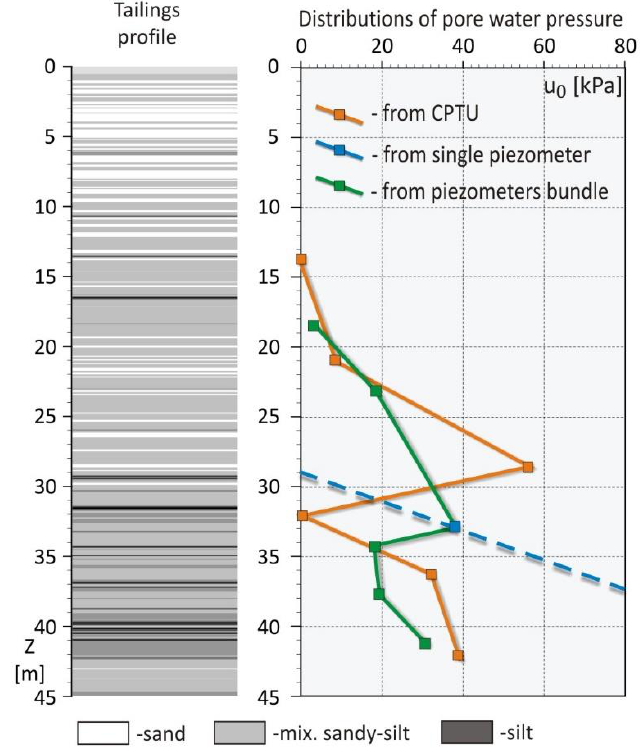
Figure 8. The comparison of water conditions in sediments with the piezometric methods and based on CPTU.